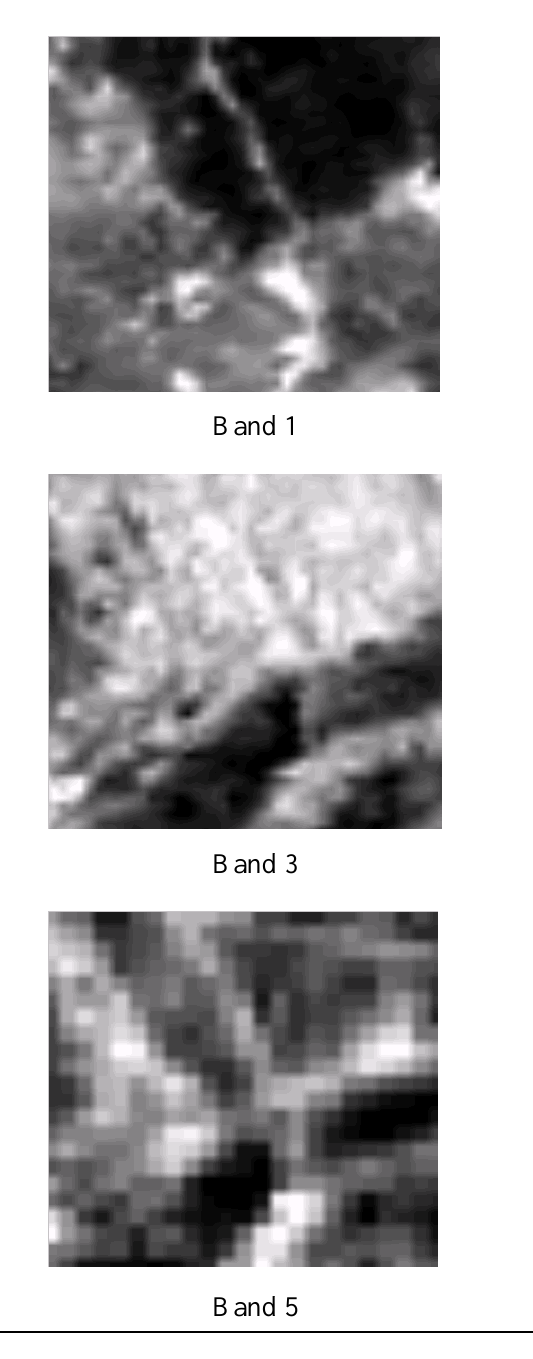
Figure 3. Multiple spectral images of MODIS data for Guatemala study